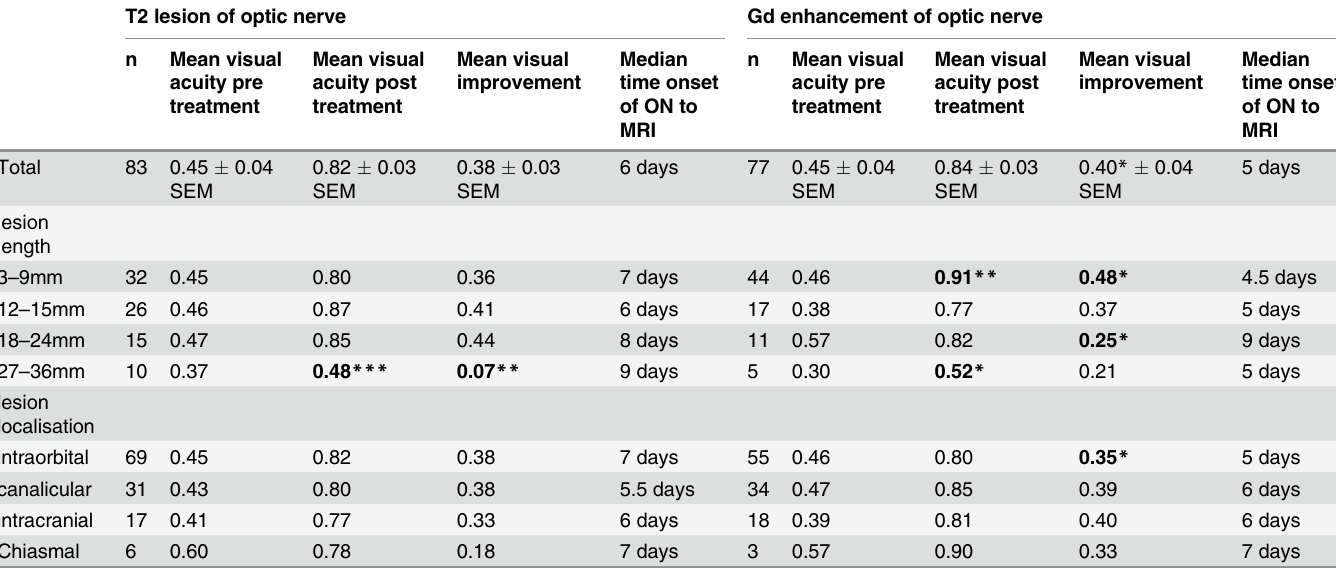
Table 5. Clinical Parameters in relation to MRI